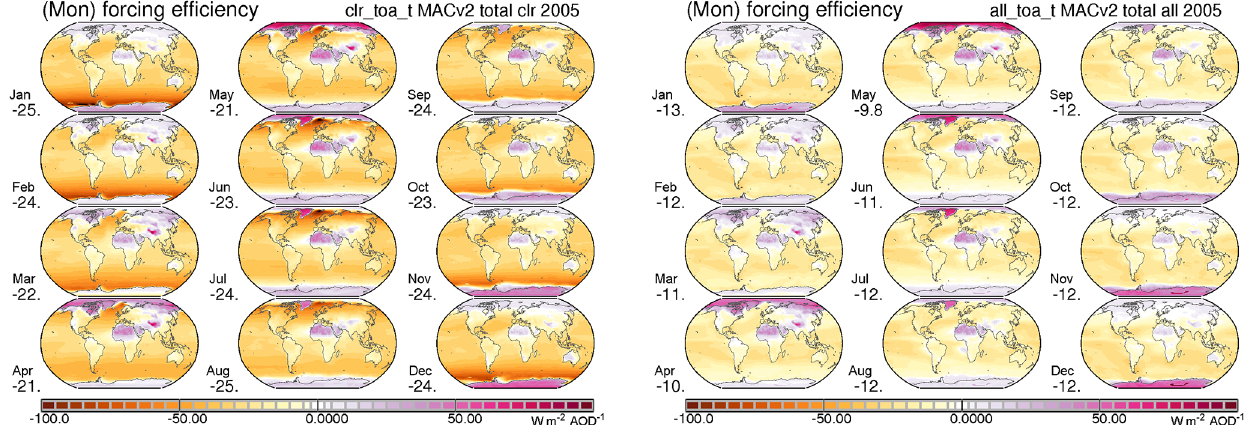
Figure D1. Monthly maps for the direct radiative forcing efficiency (per unit AOD) at the TOA by present-day total aerosol for clear-sky (left frame) and all-sky conditions (right frame). Blue colors indicate climate cooling potential and red colors warming potential. Values below the labels indicate global averages.